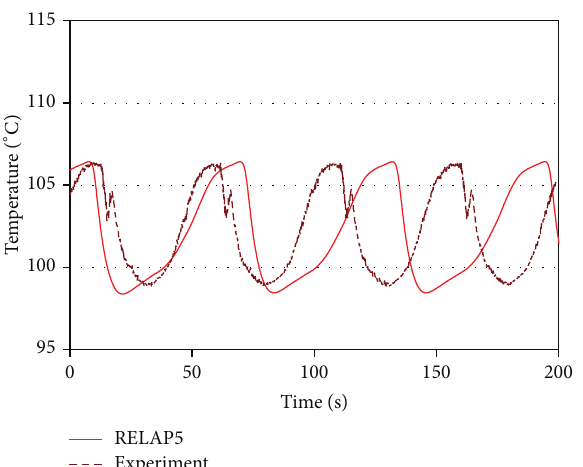
Figure 11: Middle riser water temperatures, test I-1.